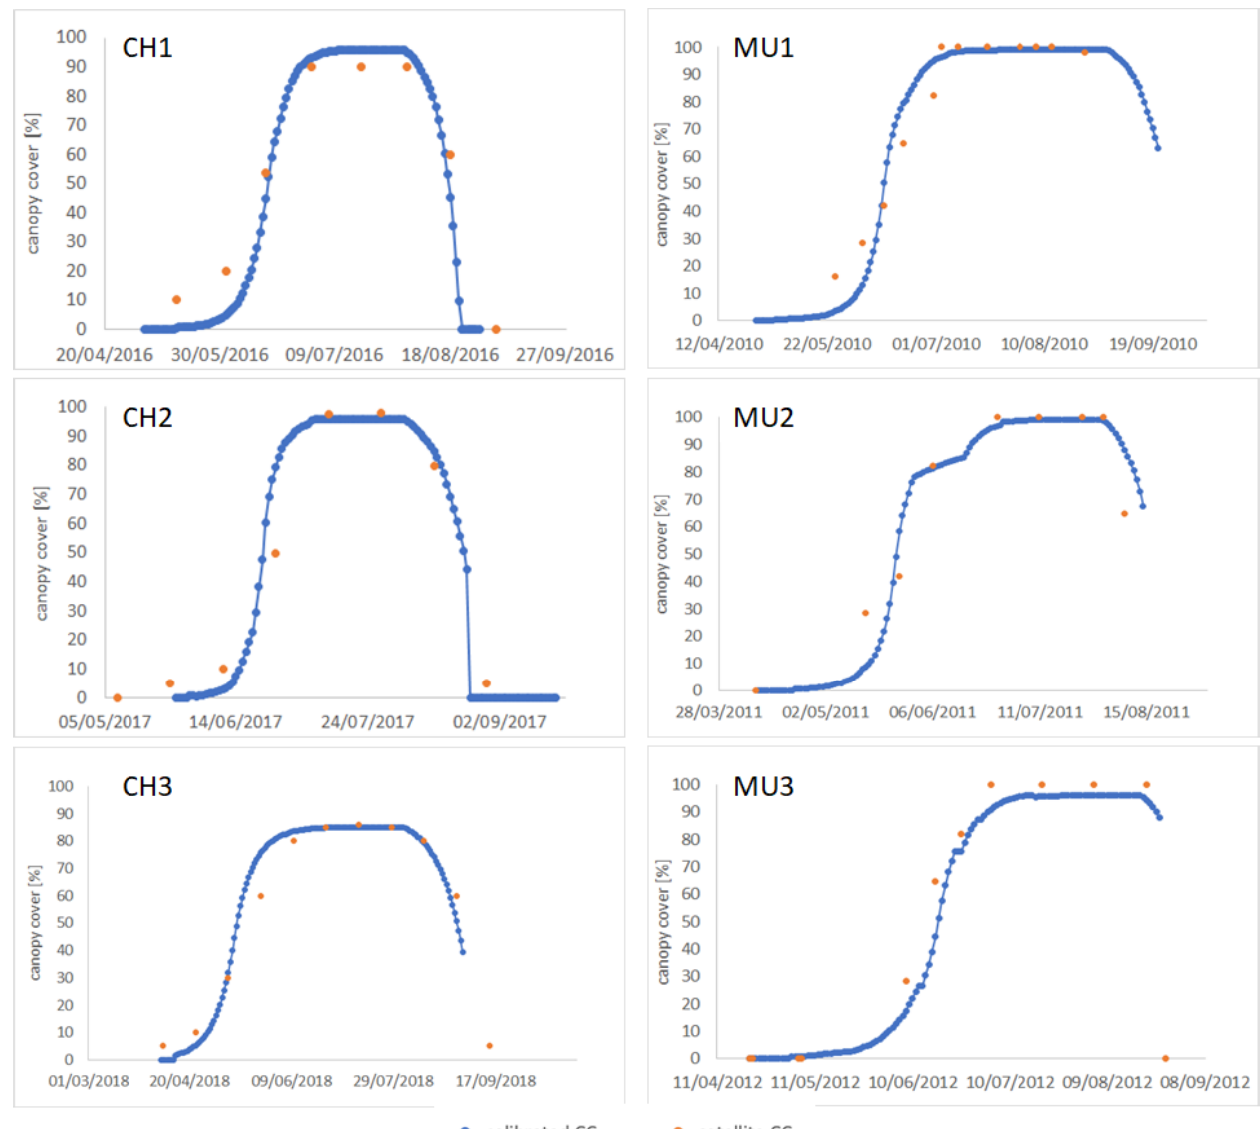
Figure 5. Modeled canopy cover for the Chiese and Muzza stations against satellite canopy cover. Table 5. Statistical indices results for the model calibration in the Chiese and Muzza Irrigation Consortia.